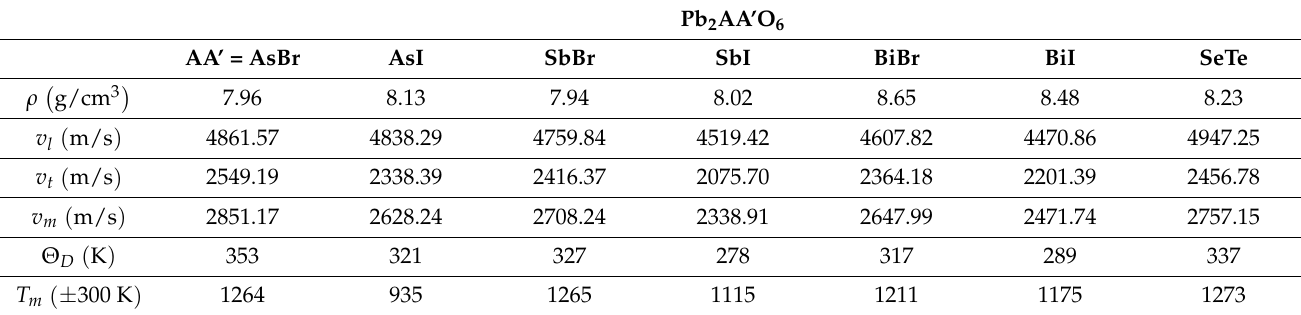
(cid:0) (cid:1) Table 3. Density ρ g/cm 3 , longitudinal v l , transverse v t , average v m , sound velocity (m/s), Debye temperature Θ D ( K ) and melting temperature T m ( K ) of the Pb 2 AA’O6 double